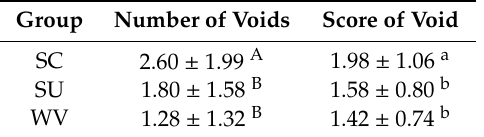
Table 3. The number of voids and scoring results of the voids in the sectioned specimens (mean ± SD). Group Number of Voids